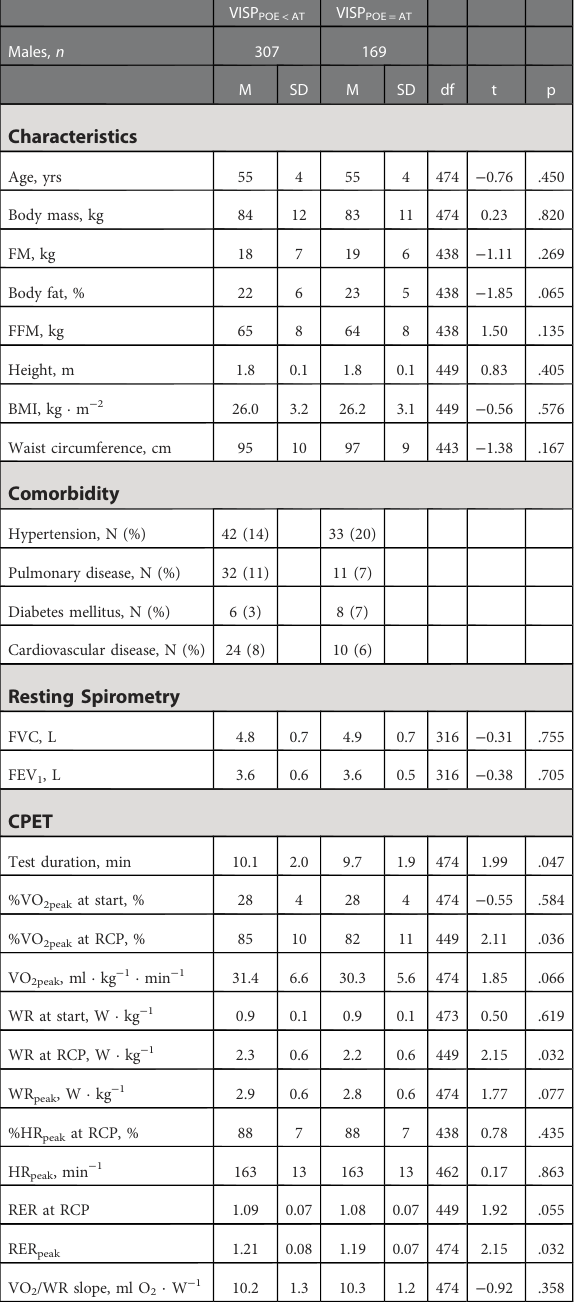
TABLE 3 Characteristics, comorbidity and main results of resting spirometry and cardiopulmonary exercise test (CPET) in VISP POE<AT and VISP POE=AT participants, separately for females and